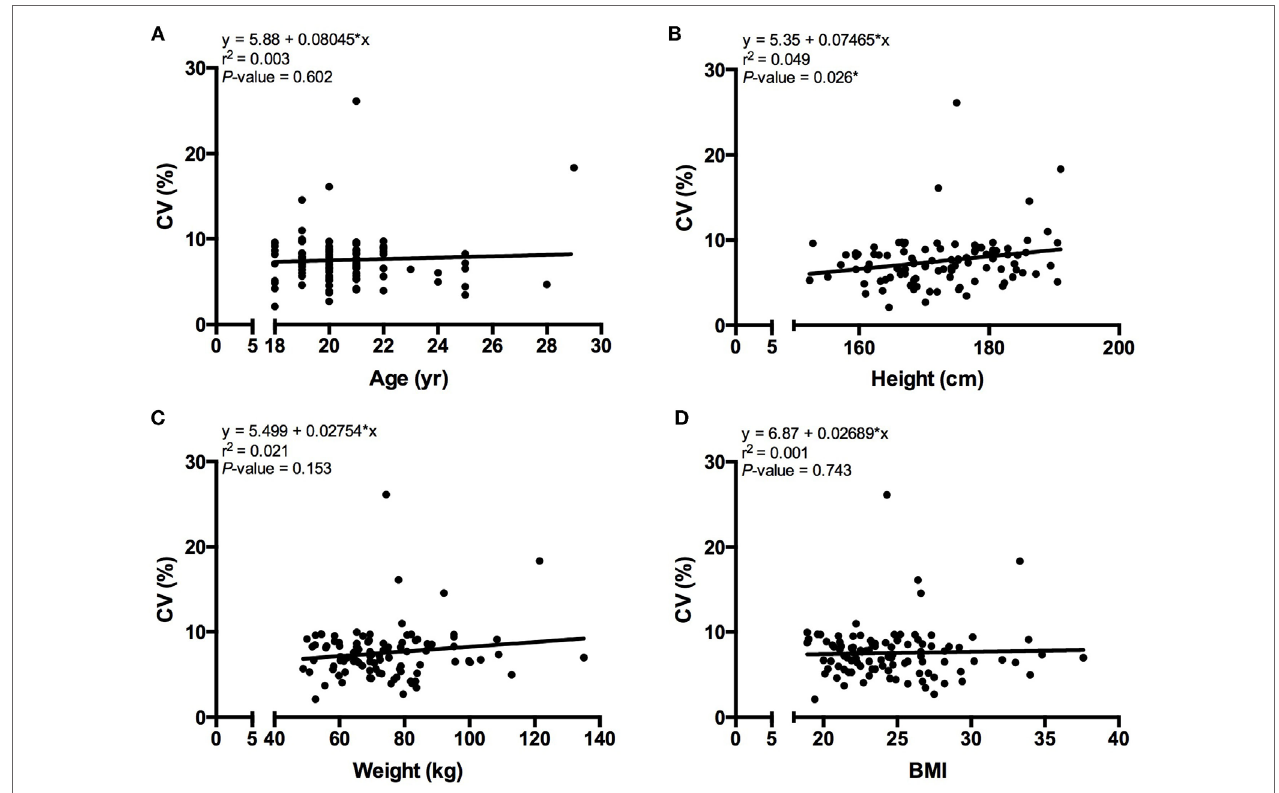
FIgURe 2 | Linear regression analysis . A linear regression analysis comparing SS %CV to (A) age, (B) height, (C) weight, and (d) BMI ( P <